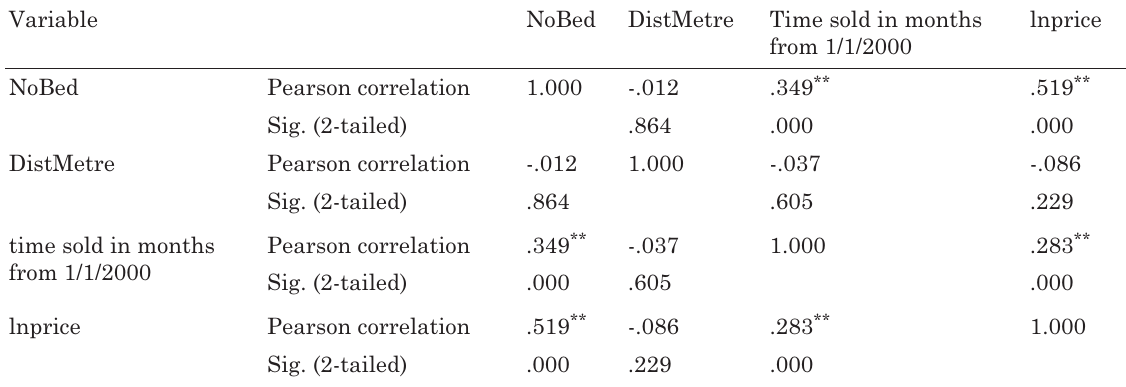
Table 4. Correlation coeffi